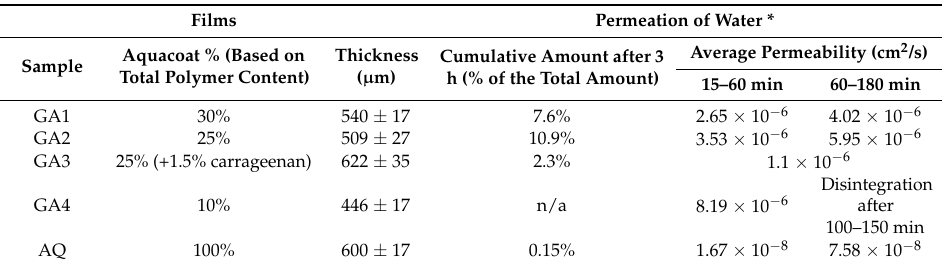
Table 3. Permeation of water through the investigated